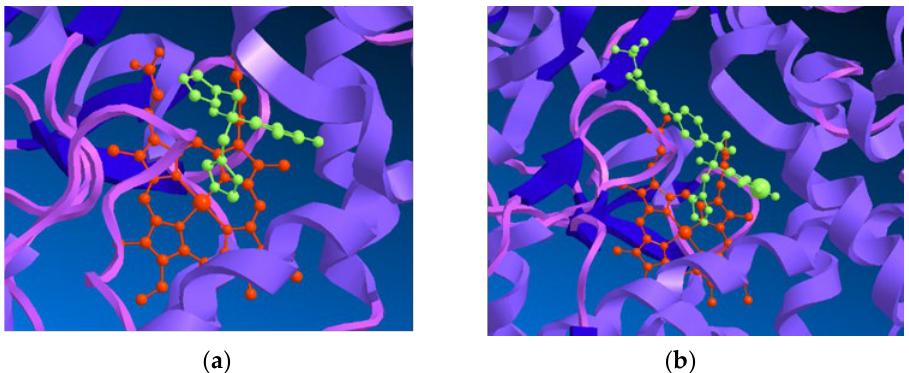
Figure 5. ( a ) Representation of the interaction of fluconazole (in green), a known triazole antifungal drug, with the heme group (in red) in the active site of CYP51 from Saccharomyces cerevisiae ; ( b ) Representation of the interaction of VT-1161 (in green), a tetrazole antifungal agent, with the heme group (in red) in the active site of CYP51 from Candida albicans . ChemBio3D was used to visualize (PDB 4WMZ and PDB 5TZ, respectively) [25,26].